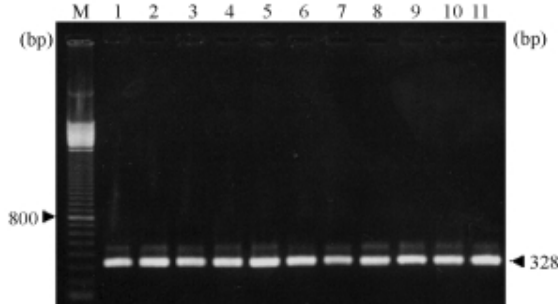
Figure 4 - PCR products from primers directed to the fur gene and strains P. CE 882R (line 1); YP 882/32R (line 2); P. Exu 340/RWB (line 3); YP 340/10W (line 4); YP 340/15W (line 5); P. Peru 375R (line 6); YP 375/4RW (line 7); YP 375/4RWB (line 8); YP 375/4WRP (line 9); YP 375/16WRP (line 10); YP 375/22W (line 11); M = 100 bp DNA